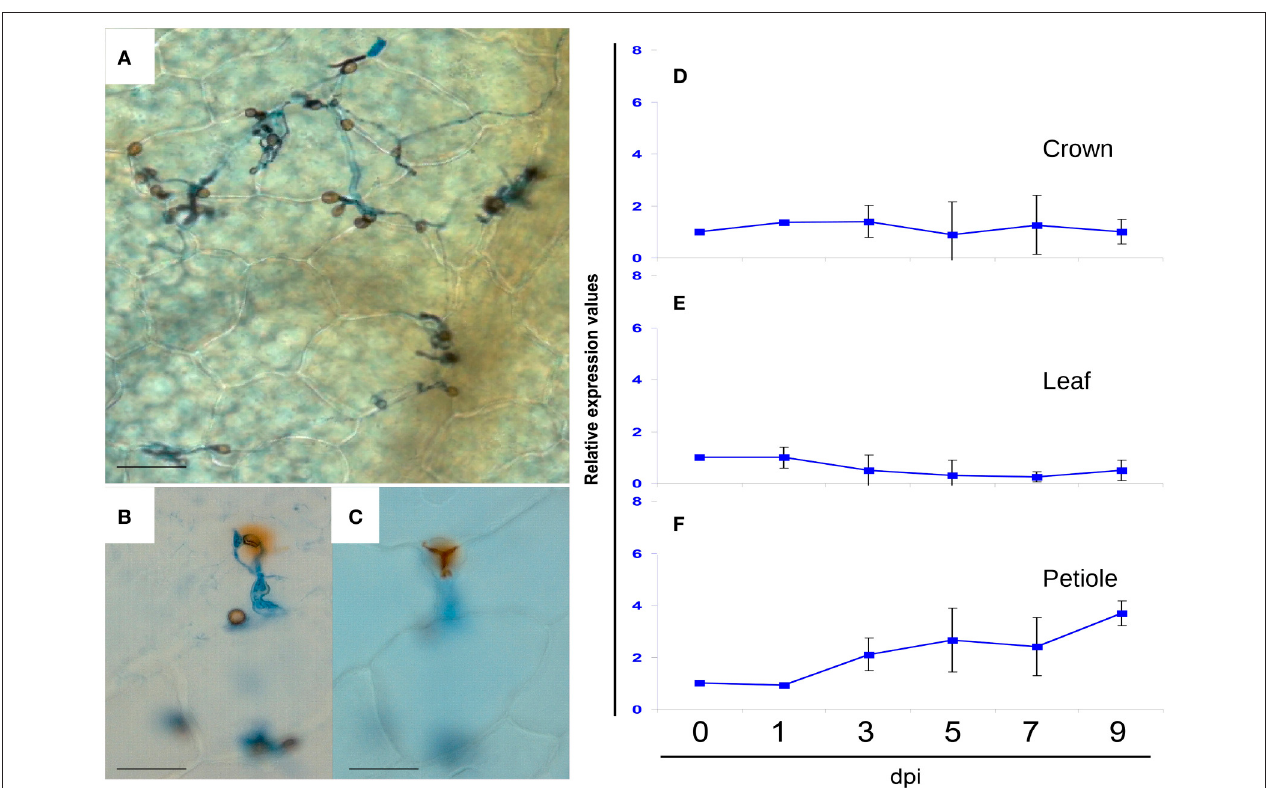
FIGURE 3 | Light microscopic analysis of DAB stained preparations of C. acutatum infected strawberry tissue at 7 dpi, and relative expression values by RTqPCR analysis of FaGST1 (At1g02930 ortholog) gene at different time points of infection. (A) Tissue sample showing no DAB reaction, (B,C) very rarely detected reduction of DAB beneath fungal appressoria, and surrounding the penetration pegs, at upper and lower focal planes, respectively. All bars 25 µ m. (D–F) Relative FaGST1 expression values. At each time point, every inoculated sample was compared with its corresponding mock treated sample. In the graphics, standard value 1 at T0 was added to better illustrate